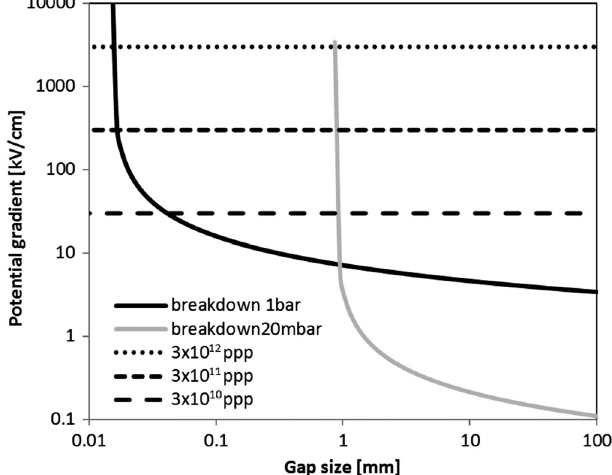
FIG. 15. Potential gradient for breakdown for helium at 20 mbar and 1 bar, and deposited maximum potential gradient for three different proton pulse intensities.